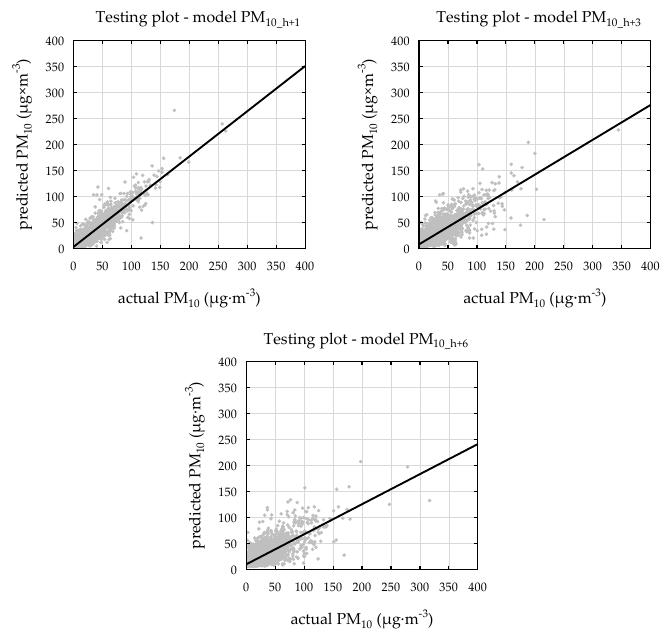
Figure 5. The testing performance plots of artificial neural networks (ANN) models (PM 10_h+1 ; PM 10_h+3 ; PM 10_h+6 ) in Sopot.